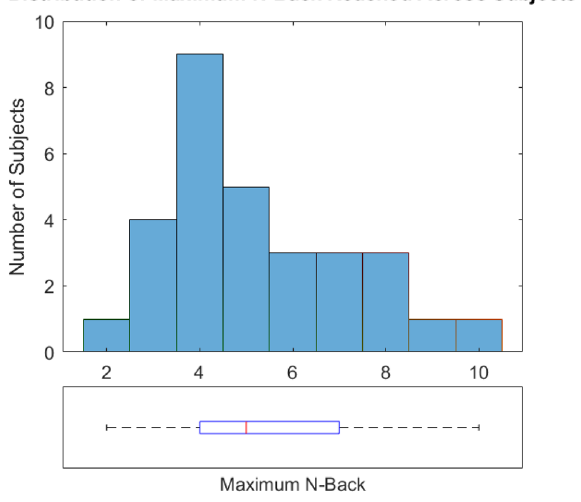
Figure 2. Distribution of maximum N-back achieved by each subject. Top plot represents a histogram of maximum N-back achieved by each participant. Bottom plot represents a box and whisker summary of the same data. The red line in the boxplot represents the median. The blue box represents the interquartile range (IQR) where the lower bound signifies the 25 th percentile (Q1) and the upper bound signifies the 75th percentile (Q3). The lower bound of the black line represents the minimum value, and the upper bound of the black line represents the maximum value.